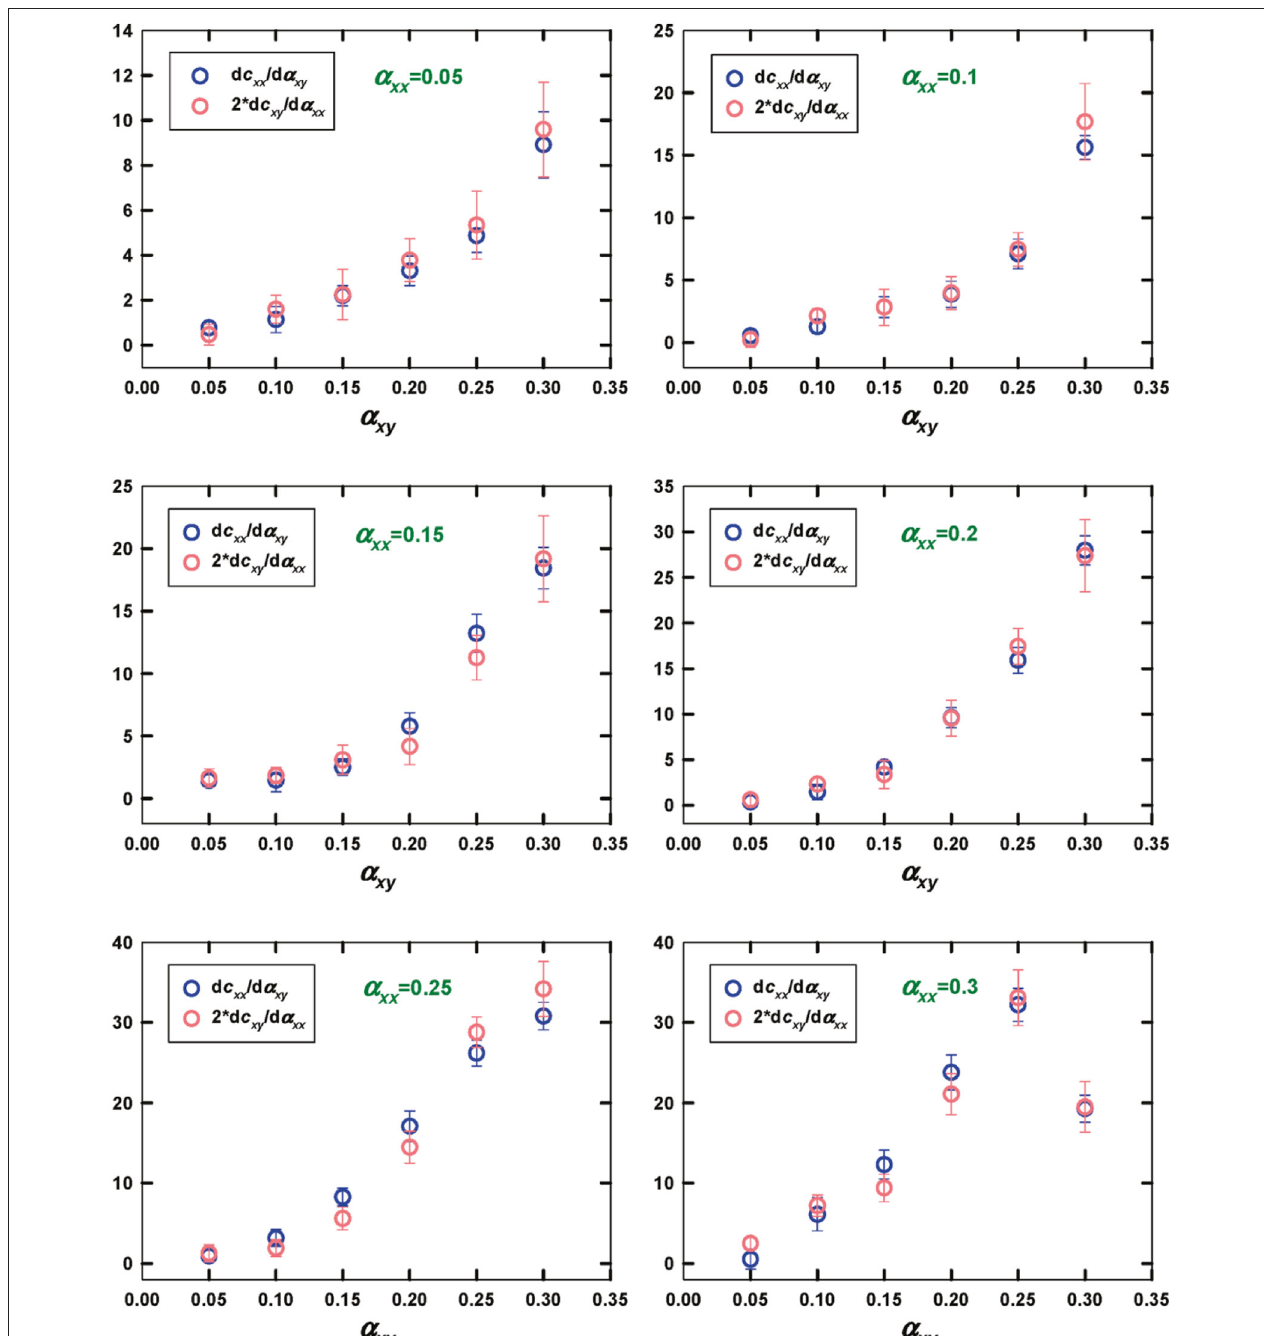
FIGURE 9 | Validity of the generalized Maxwell equation, Equation (17), from GENERIC Monte Carlo simulations with an unentangled C 78 PE melt at 450K over a wide range of fields a . Reprinted (adapted) with permission from Baig et al. [86]. Copyright (2011) American Chemical